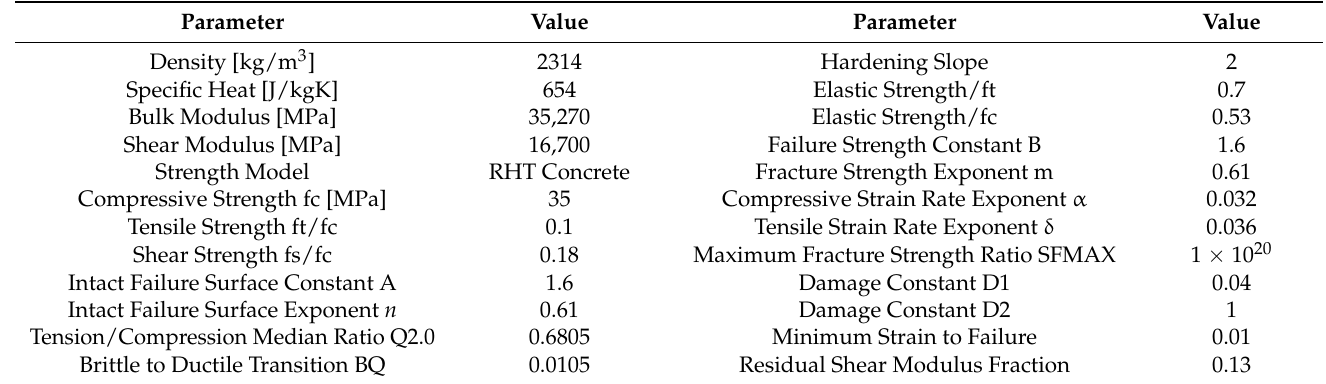
Table 1. Material parameters CONC-35MPA [23].